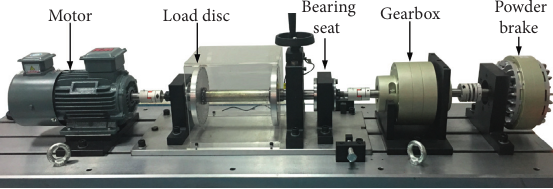
Figure 7: Test bench of bearing fault. Table 2: Diagnosis results in Experiment